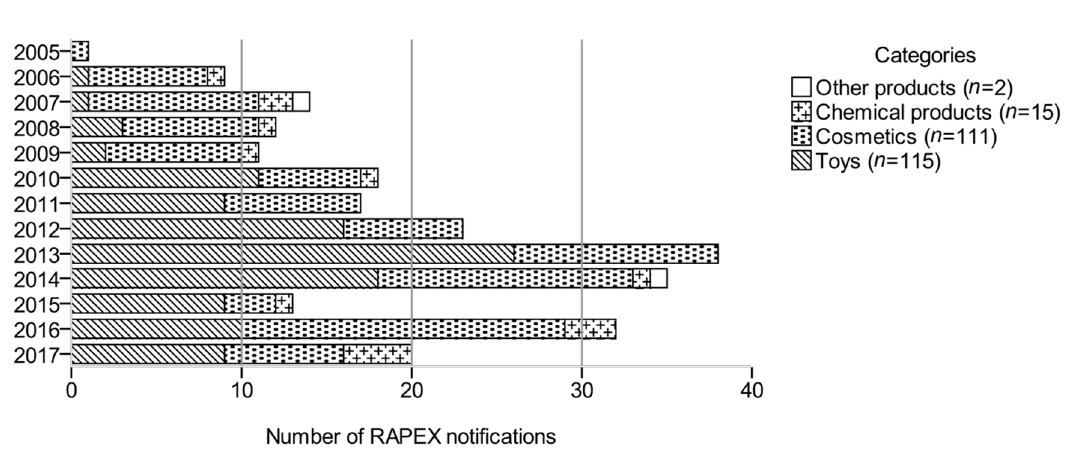
Figure 1. Figure 1. Rapid Exchange of Information System (RAPEX) notifications for products posing a microbiological risk, assigned to product categories for each year (2005–2017).